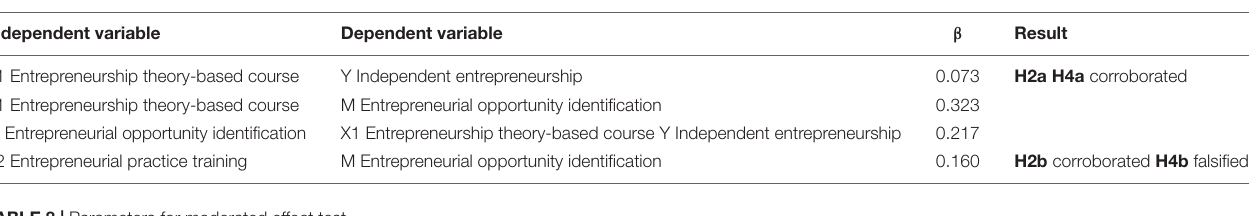
TABLE 7 | Parameters for mediating effect test.